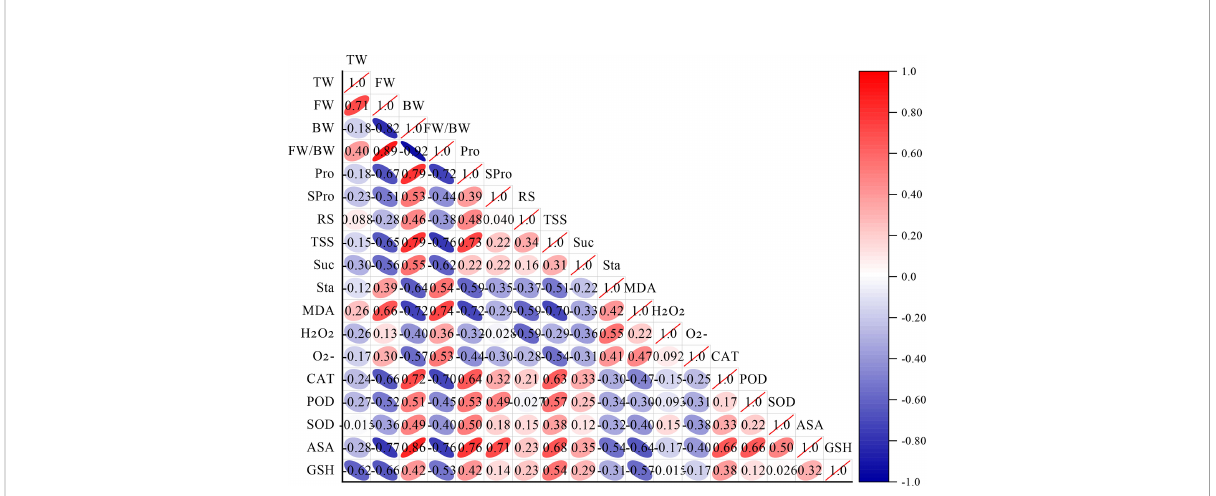
FIGURE 3 Correlation analysis of cold resistance indexes of different V. vinifera varieties. The more slender the ellipse, the larger the correlation coef fi cient. Red is positive, blue is negative. TW (Total water content), FW (Free water content), BW (Bound water content), FW/BW (The ratio of FW/BW), Pro (Proline content), SPro (Soluble protein content), RS (Reducing sugar content), TSS (Total soluble sugar content), Suc (Sucrose content), Sta (Starch content), MDA (Malondialdehyde content), H 2 O 2 (hydrogen peroxide content), O − 2 (Superoxide anions content), CAT (Catalase content), POD (Peroxidase content), SOD (Superoxide dismutase content), ASA (Ascorbic acid content), GSH (Reduced glutathione